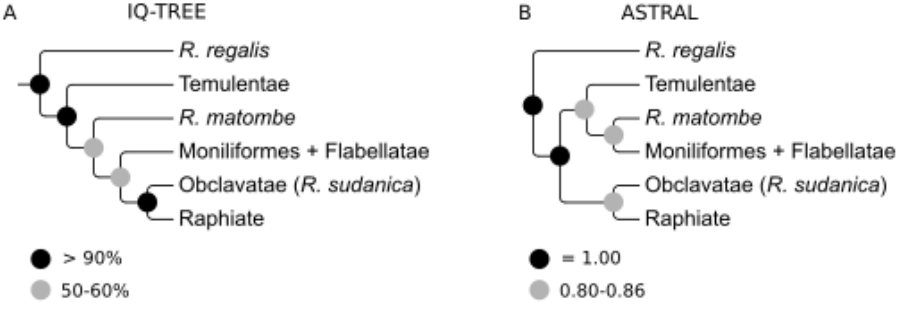
Figure 2. Major incongruences between the ( A ) concatenation (IQ-TREE) and ( B ) gene tree (ASTRAL) phylogenetic approaches. Both trees have been modified to show the relationships among major Raphia clades. Support values are indicated on the nodes as either (a) bootstrap or (b) local posterior